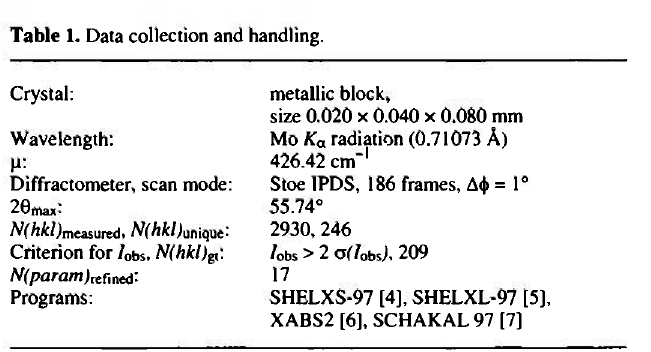
Table 2. Atomic coordinates and displacement parameters (in Ä 2 ).